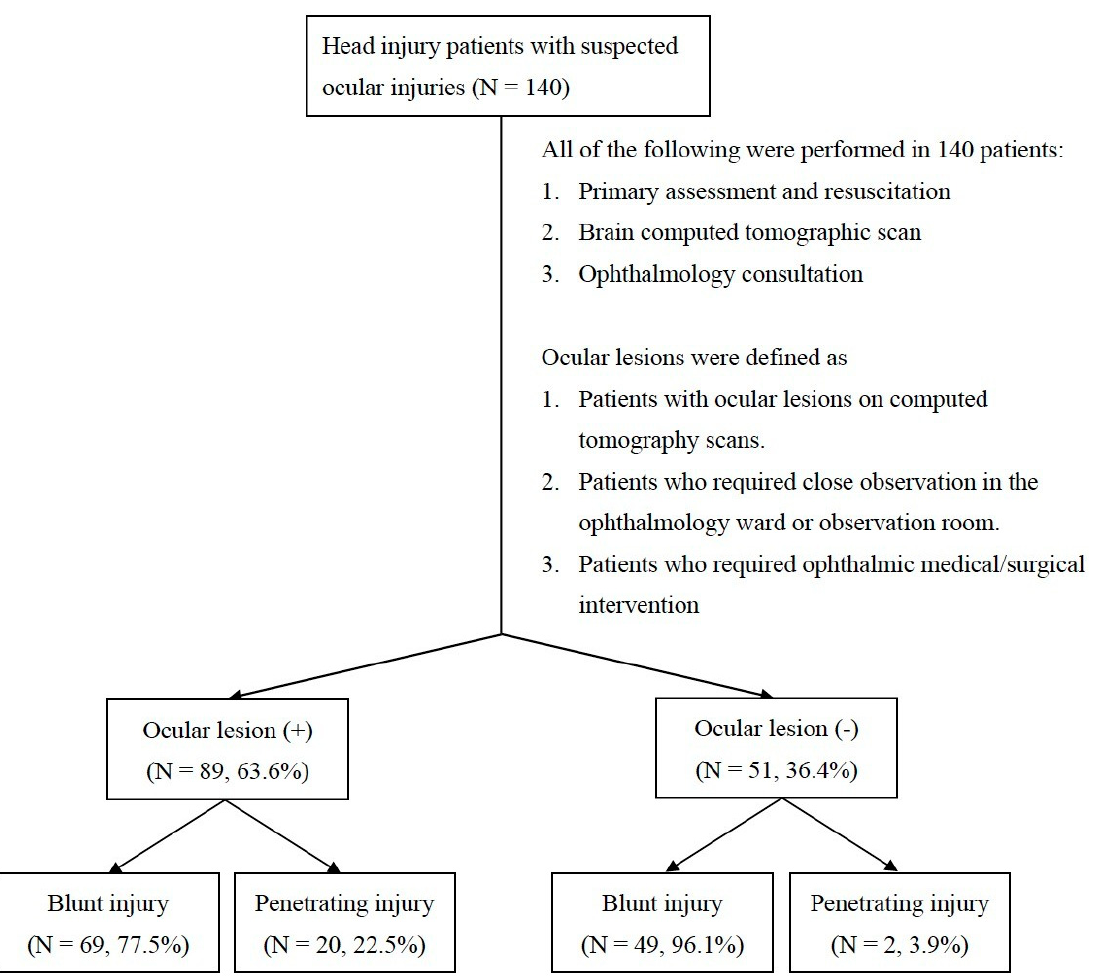
Figure 1. A total of 140 head injury patients underwent primary assessment, resuscitation, brain CT and ophthalmology consultation in the emergency department. Eighty-nine patients were defined as ocular lesion (+), and 51 patients were defined as ocular lesion ( − ). In each group, patients were subcategorized according to the mechanism of injury (either blunt or penetrating injury).